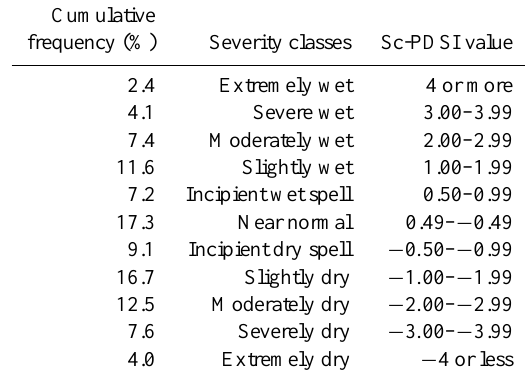
Table 1. Cumulative frequency, severity classes, and SC-PDSI val- ues in the Carpathian